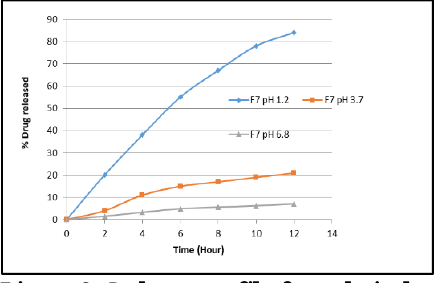
Figure 8. Release profile for relatively pH- independent ITZ floating microparticles at various pH.